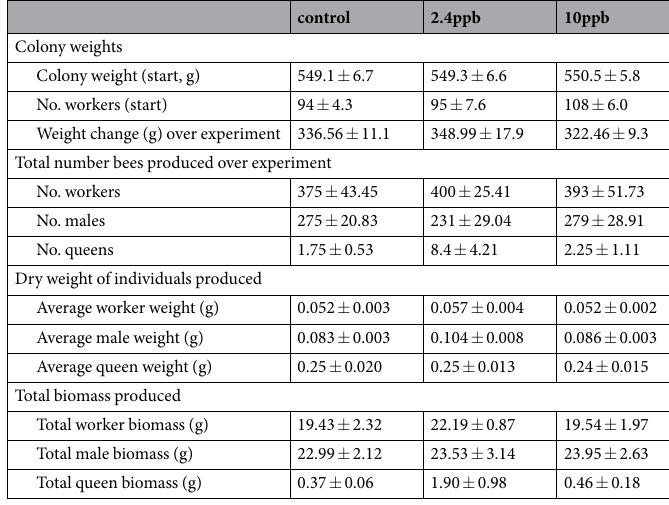
Table 1. Means ( ± standard error) of the variables measured per Bombus terrestris colony. N = eight colonies per treatment (24 colonies in